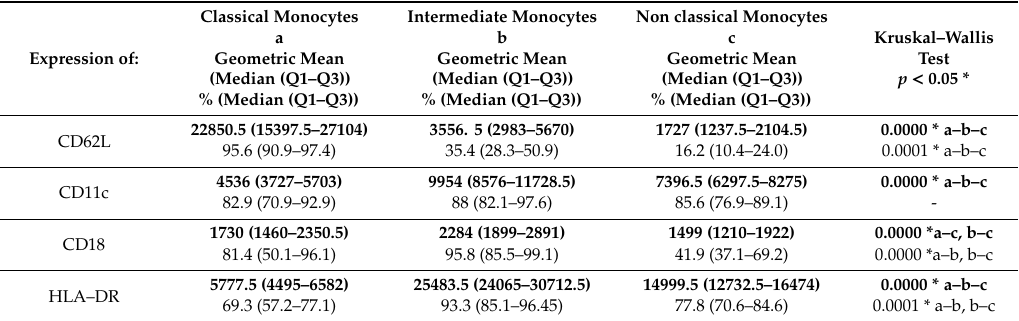
Table 4. Median proportion and median geometric means expression of CD62L, CD11c, CD18 and HLA-DR markers on three types of monocytes in control group. * p < 0.05 as statistically